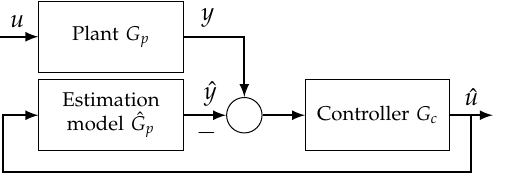
Figure 3. Block diagram of the YCOO estimation